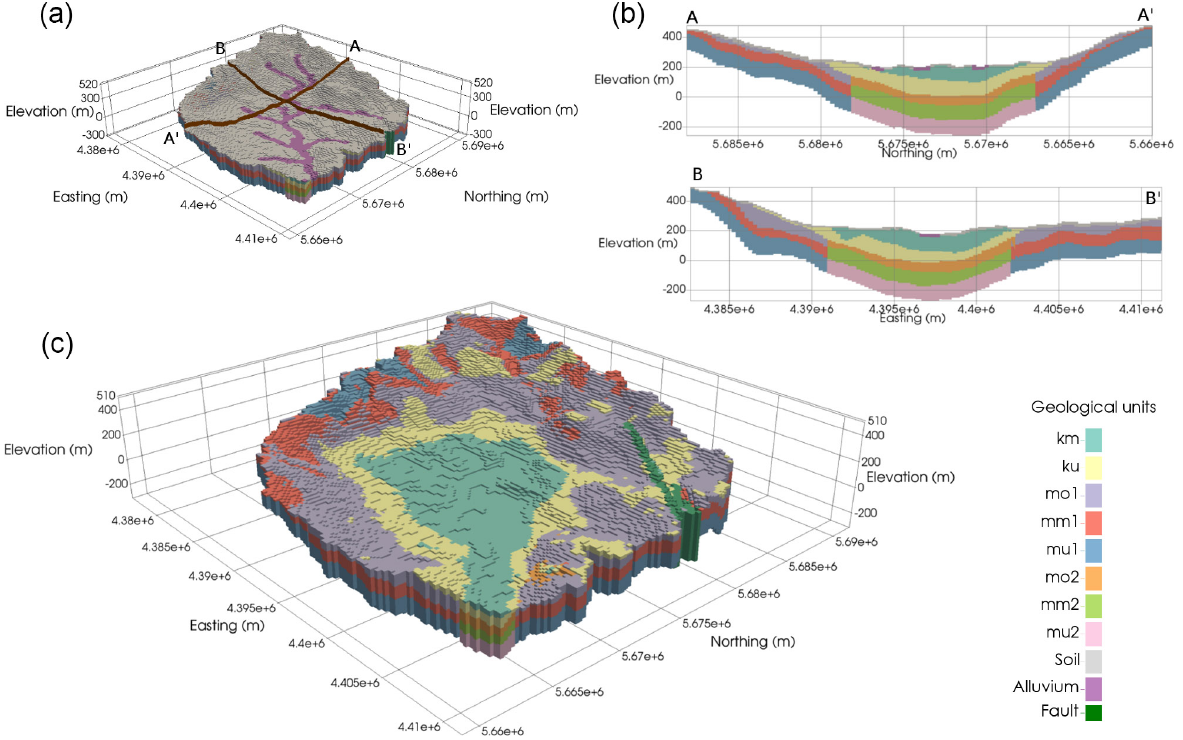
Figure 4. Three-dimensional and cross-sectional views of the hydrogeologic zonation in the Nägelstedt catchment. Panel (a) highlights the distribution of alluvium and soil zones. Panel (b) shows two vertical geological cross sections. Panel (c) shows the detailed zonation of geological sub-units beneath the soil zone and alluvium.